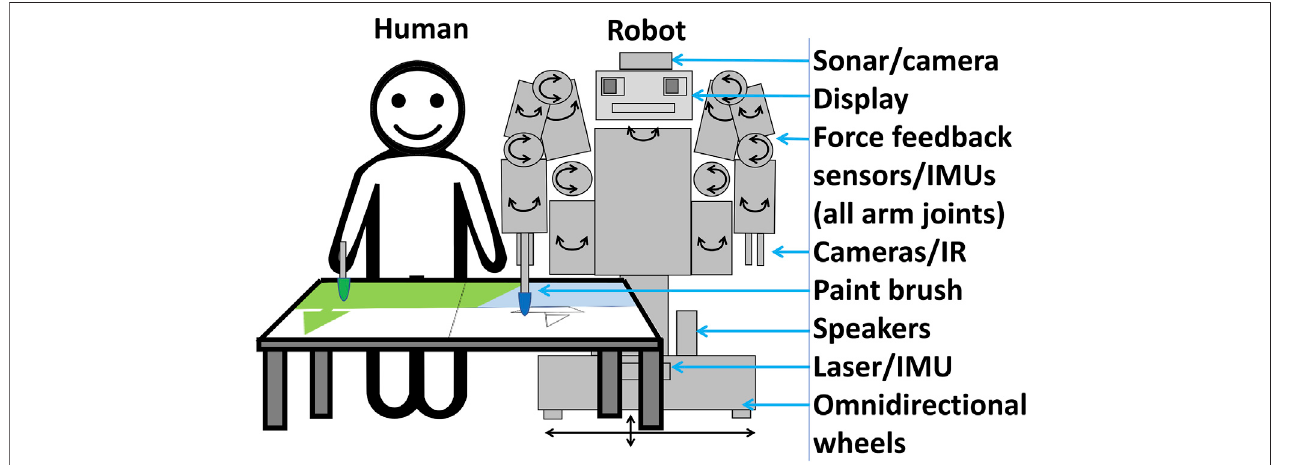
FIGURE 1 | Basic concept. A social robot could interact with people in emotional and creative contexts such as art-making, that provide enjoyment or therapeutic value, given some strategies for personalization and expression through art.